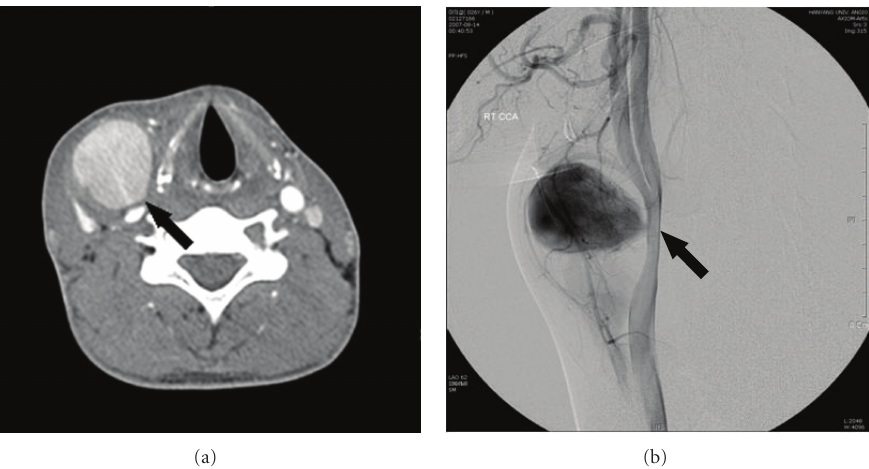
Figure 1: (a) Contrast-enhanced CT angiogram demonstrating a 3 × 3cm sized pseudoaneurysm (arrow) at the right common carotid artery. (b) Right carotid angiogram demonstrating a pseudoaneurysm (arrow) arising from the right common carotid